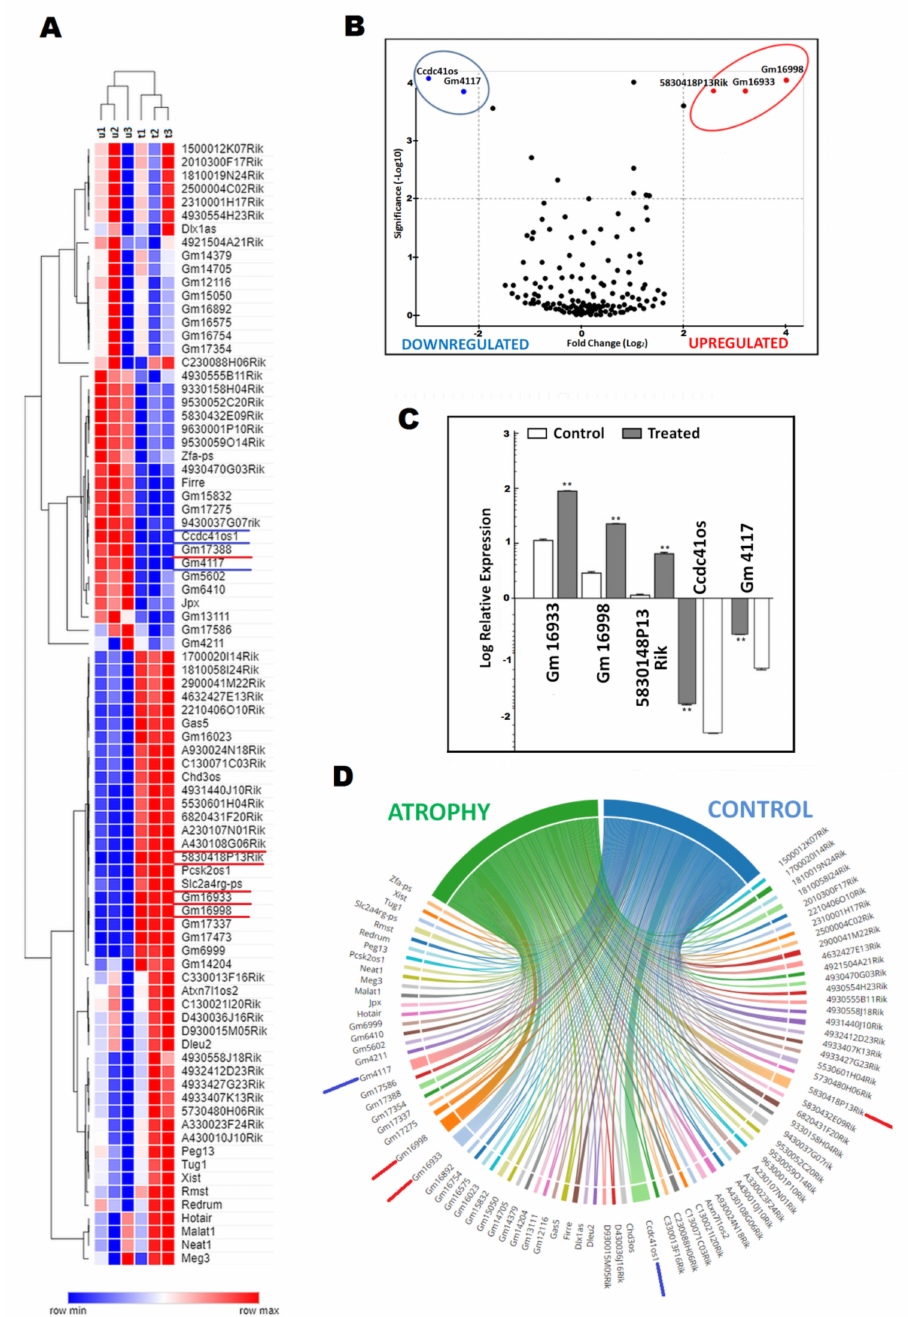
Figure 2. Identification of DElncRNAs between C2C12 myotube atrophy and control C2C12 cells in a discovery set: ( A ) heat map of 84 lncRNAs demonstrating at least a 2-fold expression difference between samples; ( B ) volcano plot illustrating differences in expression of 176 lncRNAs between samples as well as the top significant DElncRNAs; ( C ) expression differences of the top five DEl- ncRNAs between atrophic C2C12 myotube culture and control cells; ( D ) chord diagram illustrating connections/relationship between lncRNAs demonstrating at least a 2-fold expression difference and either atrophic or non-atrophic conditions in C2C12 myotube culture. (** p < 0.001 compared to control